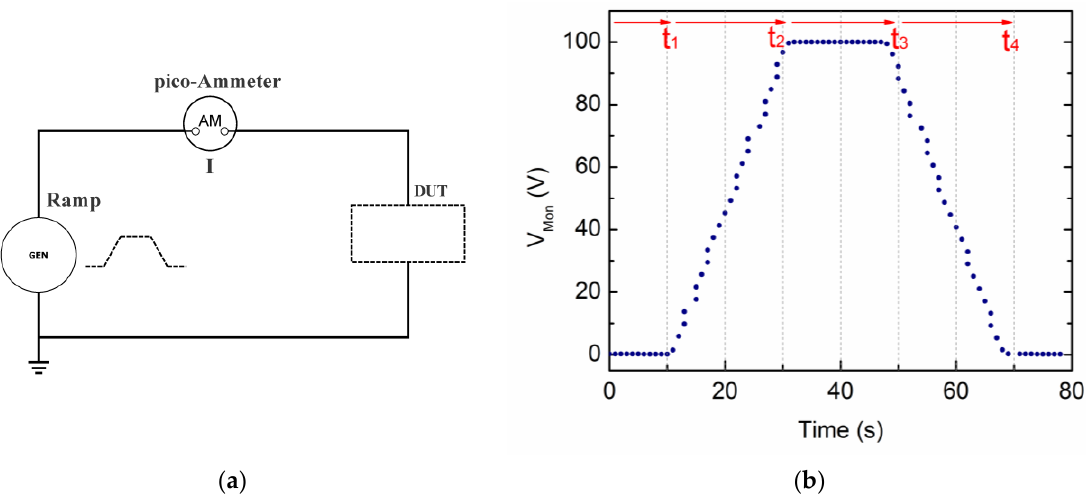
Figure 1. ( a ) Schematic circuit of the experimental VRM setup; ( b ) input voltage cycle used for VRM tests as directly monitored by the HV Power Supply. The ramp-up and ramp-down rates were set to 5 V/s and maximum voltage was set to 100 V. Each measurement cycle lasted approximately 100 s.